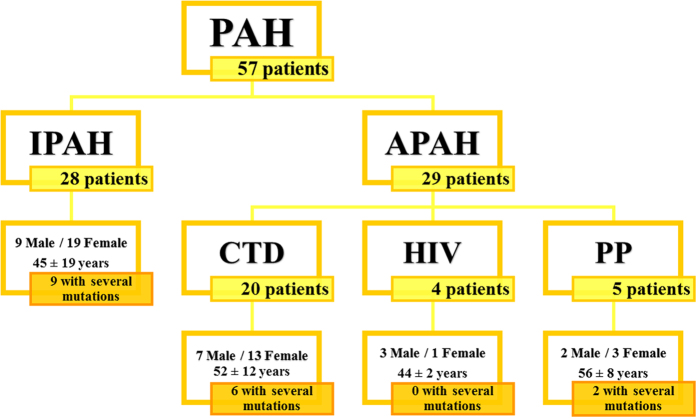
Graphical representation of the patients included in this study and their clinical features.Age displayed is the age at diagnosis. PAH: Pulmonary Arterial Hypertension; IPAH: Idiopathic Pulmonary Arterial Hypertension; APAH: Associated Pulmonary Arterial Hypertension; CTD: connective tissue disease; HIV: Human Immunodeficiency virus; P-P: Porto-pulmonary hypertension.